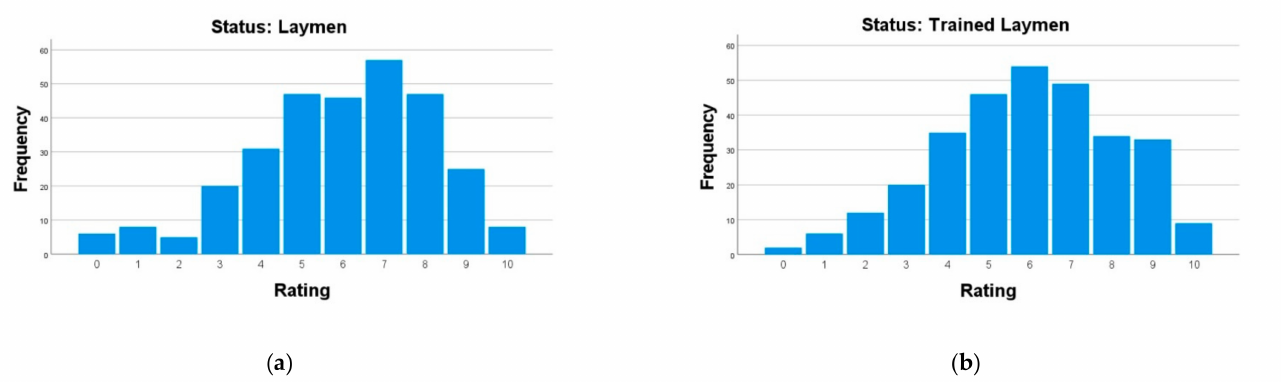
Figure 2. Evaluation of ( a ) laymen and ( b ) trained laymen.